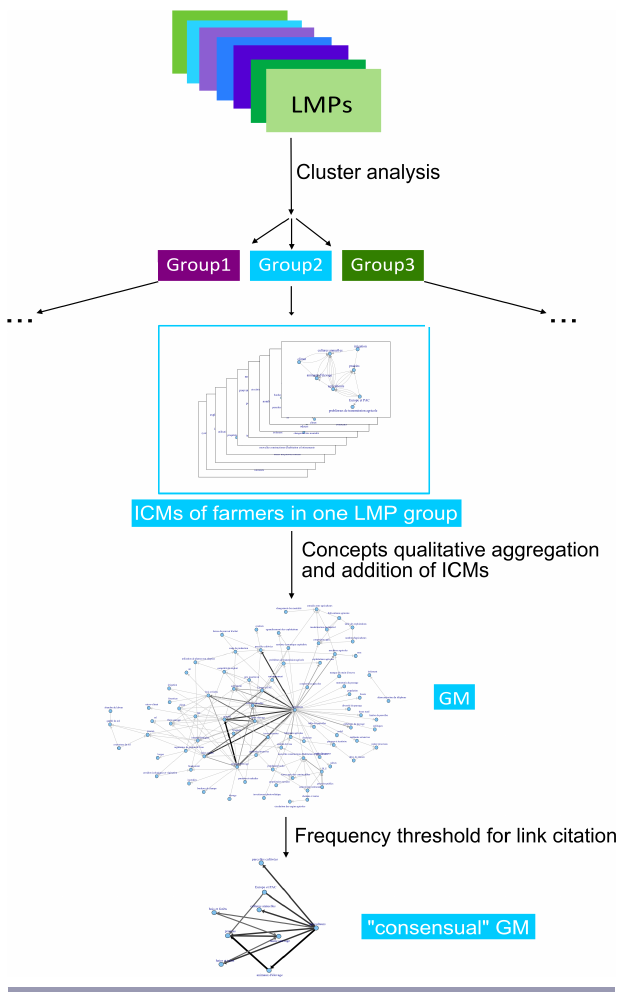
Fig. 2. Conceptual framework developed to compare individual mental models (IMMs) and land management practices (LMPs) illustrating the main steps of the approach used to generate a “shared” group map (GM) for a group of farmers with similar LMPs. Darker and wider arrows have higher weight, i.e., higher frequency of citation by farmers in that group. Individual multiple links made by farmers between two concepts are merged when these links have the same direction (but different verbs are maintained). ICM = individual conceptual